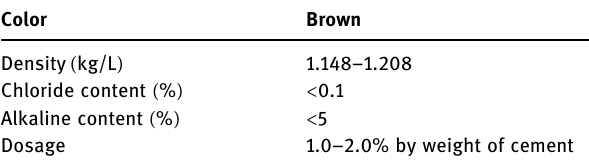
Table 5: Properties of SP Color